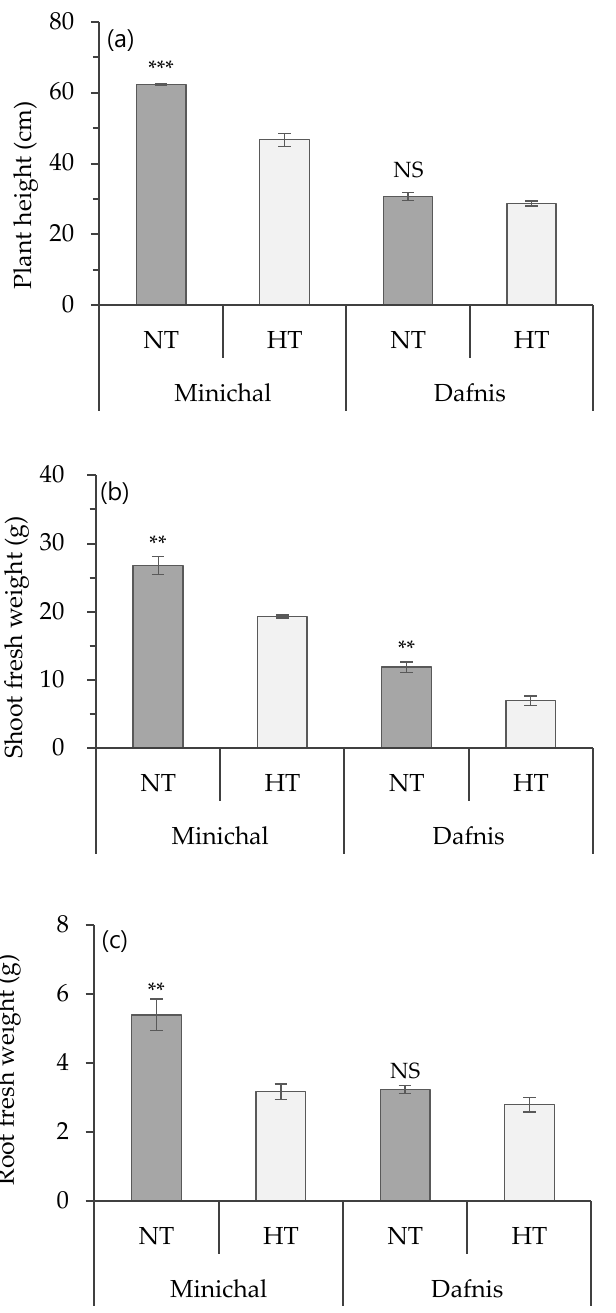
Figure 5. Electrolyte conductivity ( a ) and proline content ( b ) as affected by different heat treat- ment days in tomato seedlings of Minichal and Dafnis grown at 40 °C. Vertical bars represent ± SE (n = 3). Means with different letters indicate significant differences at p ≤ 0.05.